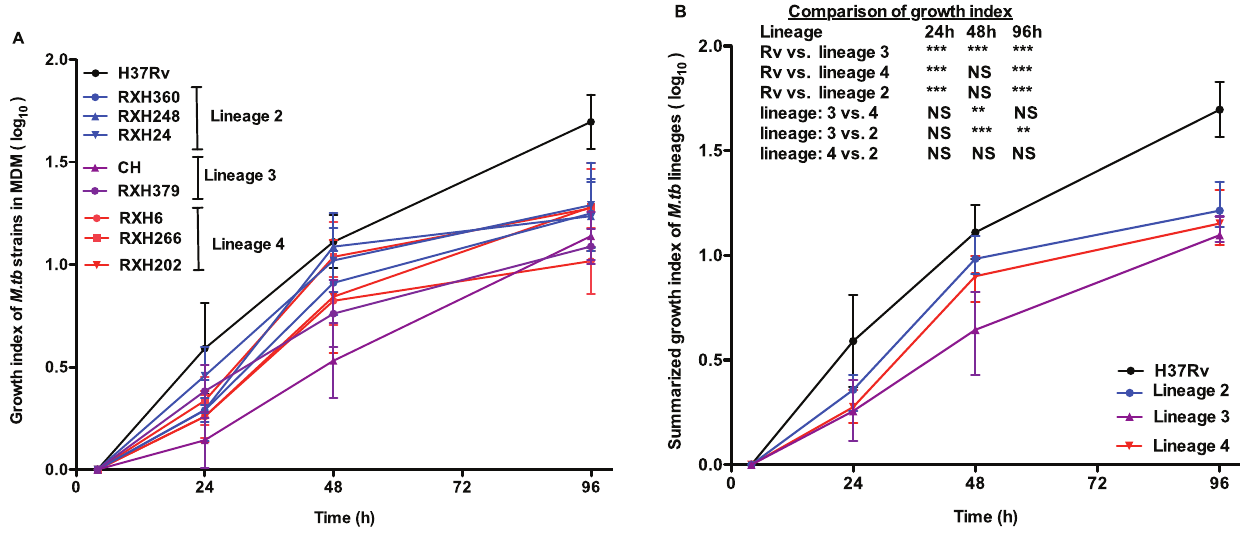
Figure 3. Growth index reflecting the intracellular growth of M.tuberculosis strains in MDM. Fig. (3A) Growth index of M. tuberculosis strains (calculated by the CFU at each time point divided by the CFU at initial time point). Fig. (3B) Summarized growth index of M. tuberculosis strain lineages. Data represent the mean 6 SD (n=7). Statistical significance is denoted as *p , 0.05, **p , 0.01, ***p , 0.001.